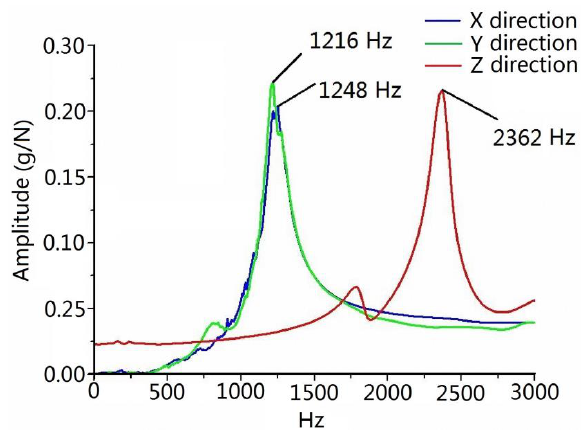
Figure 10. Frequency and amplitude result of the impacting modal test.